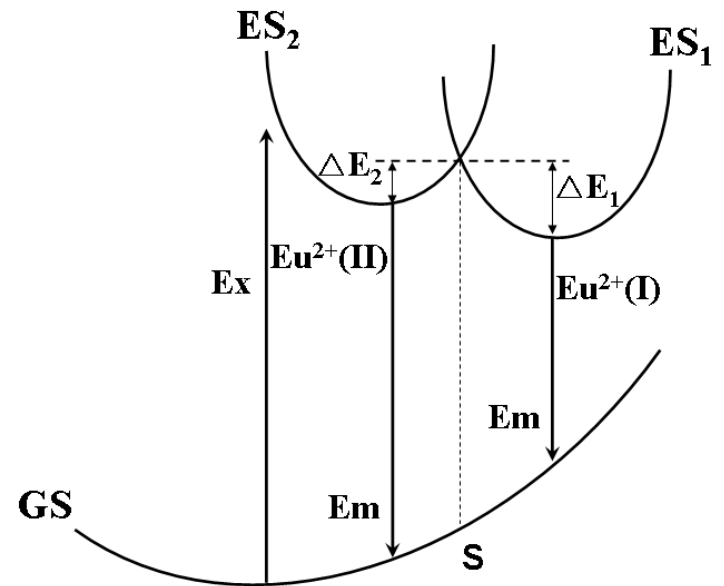
Figure 24. Thermally active phonon-assisted tunneling of Eu 2+ from low-energy site to high-energy site in configuration-coordinate